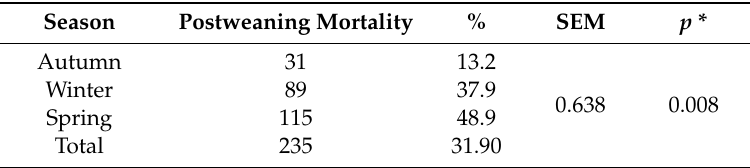
Table 5. Seasonal prevalence of postweaning